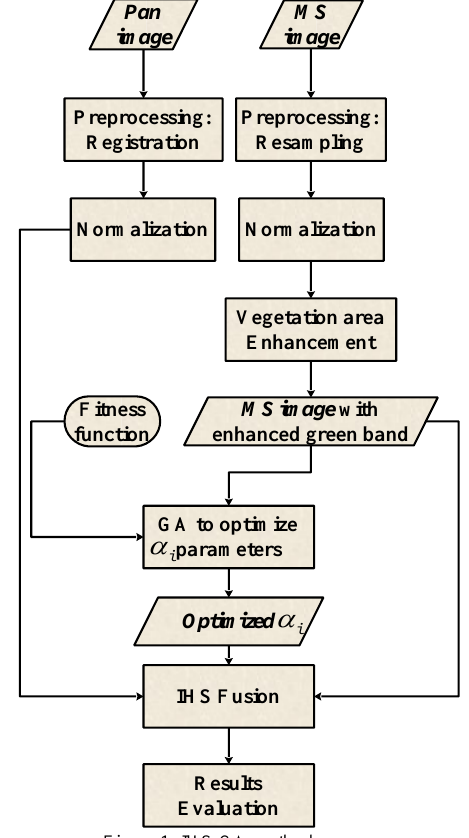
Figure 1. IHS-GA